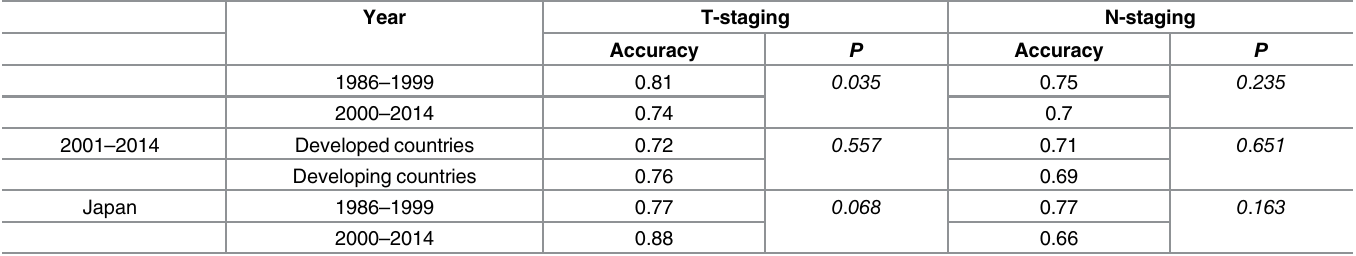
Table 3. Diagnostic accuracy of EUS in T/N staging for ESCC over 1986 –